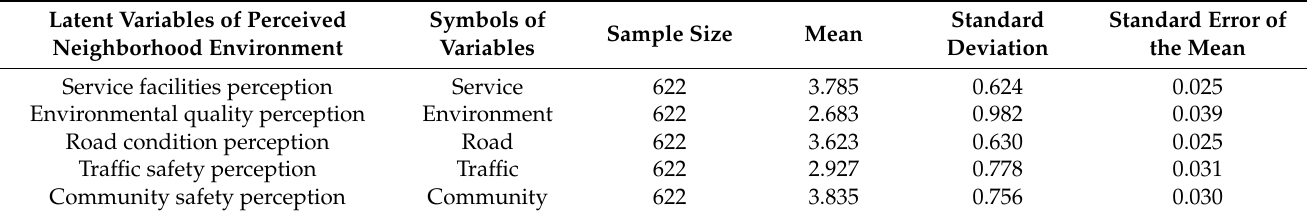
Table 6. Mean, standard deviation and standard error of latent variables of perceived